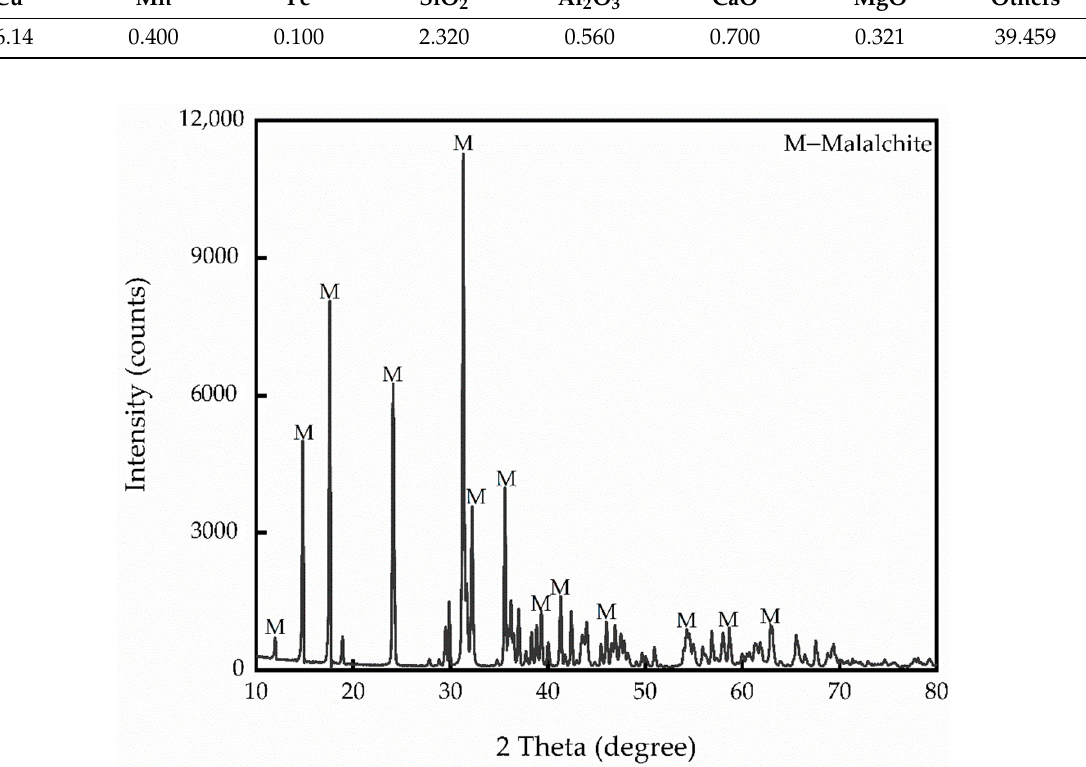
Figure 1. X-ray diffraction of malachite sample. Table 1. The analysis of malachite composition by XRF.